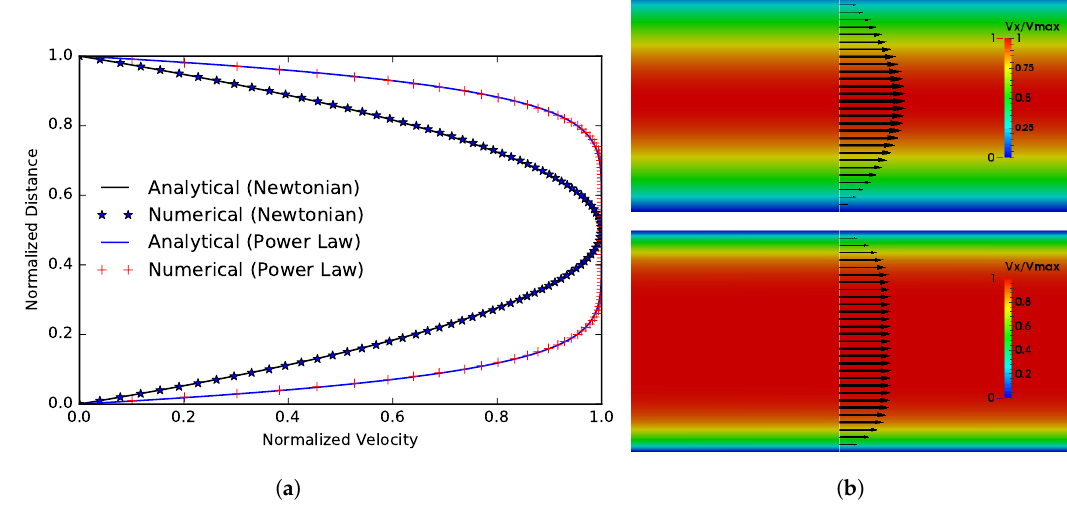
Figure 5. Comparison between numerical simulation and analytical solutions of the flow between two parallel plates, we set κ = 10 − 6 Pa.s n and n = 0.2 for the non-Newtonian fluid. ( a ) Axial velocity profiles; ( b ) Axial velocity vector and contour for the Newtonian ( top ) and Non-Newtonian ( bottom ) cases.